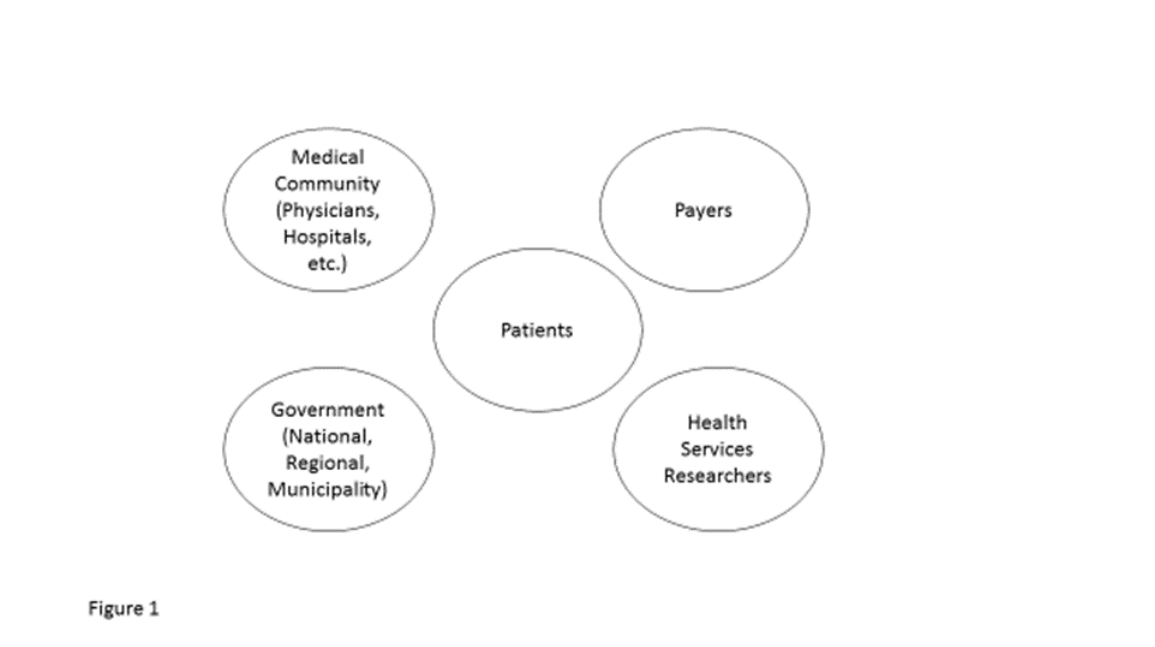
Figure 1: Health system